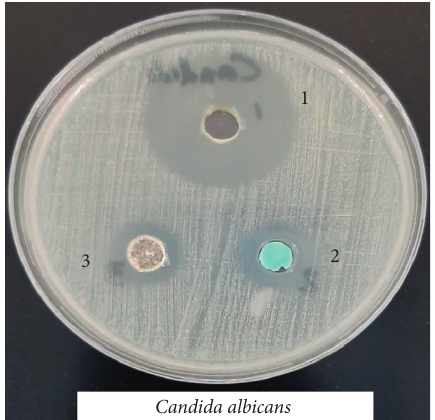
Figure 15: Microbiological screening of Ni(II), Cu(II) and Mn(II) complexes with S. epidermidis.